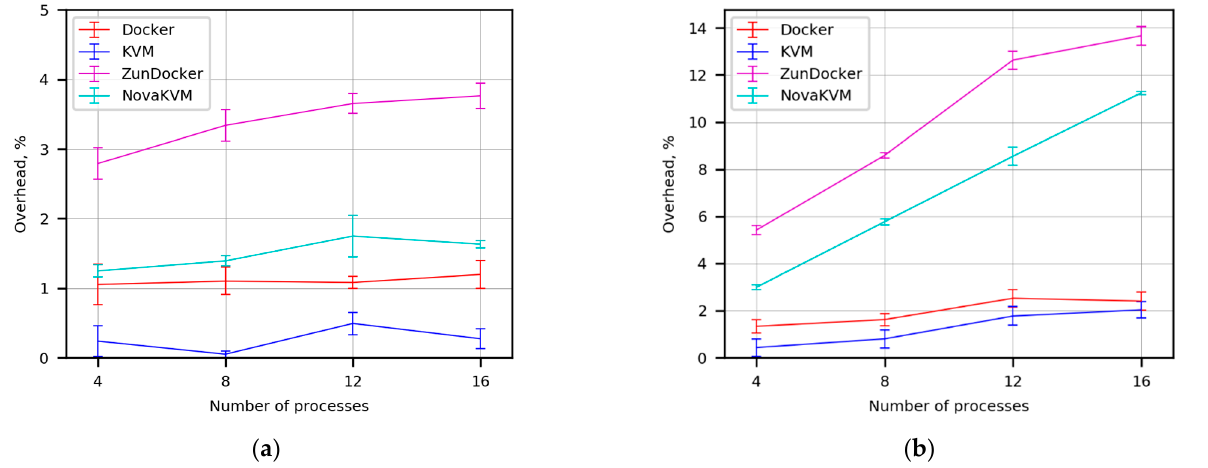
Figure 9. Overhead of the cloud infrastructure in ( a ) computing time and ( b ) total execution